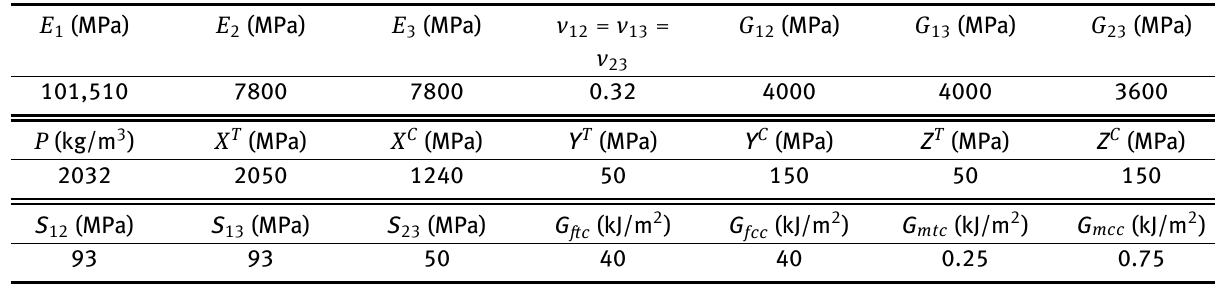
Table 4: Material properties of used T700 carbon fiber/epoxy prepregs.